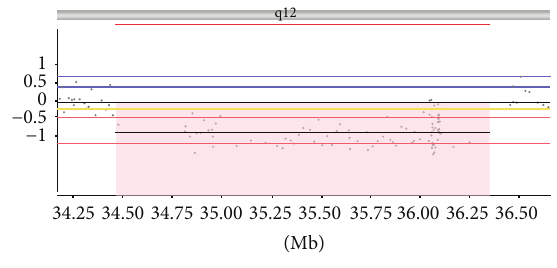
Figure 3: 400K CGH + SNP array result: 17q12 (34,464,879– 36,352,140) × 1. 17q12 region genes: AATF , ACACA , C17orf78 , CCL3L1 , CCL3L3 , CCL4L1 , CCL4L2 , DDX52 , DHRS11 , DUSP14 , GGNBP2 , HNF1B , LHX1 , LOC284100 , LOC440434 , MIR2909 , MIRM1 , MYO19 , PIGW , SYNRG , TADA2A , TBC1D3 , TBC1D3B , TBC1D3C , TBC1D3F , TBC1D3G , TBC1D3H , and ZNHIT3